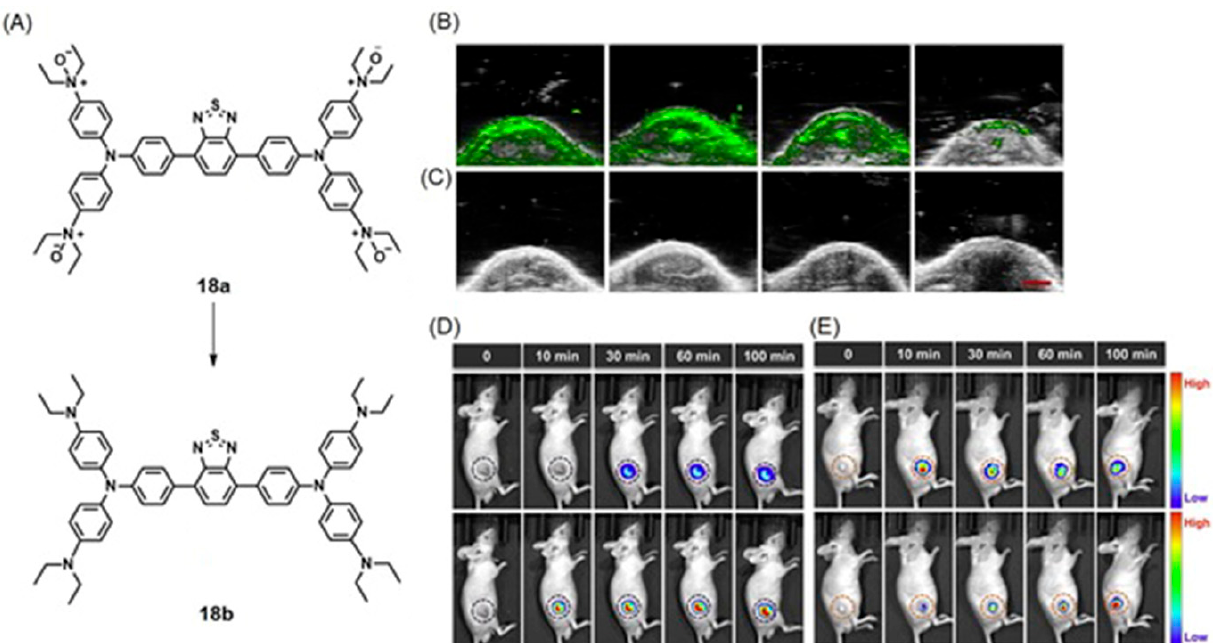
Figure 41. ( A ) Chemical structures of 18a and 18b . Time-dependent in vivo photoacoustic images of the tumor region in mice after tail vein injection of ( B ) nanoparticles of 18a (200 μ L, 1 mg mL –1 ) and ( C ) saline (200 μ L) as control. (Left to right) Images were obtained after 6, 24, 48, and 72 h post-injection of nanoparticles. Scale bar = 2 mm. A strong photoacoustic signal was detected 6 h post-injection demonstrating the responsiveness of 18a to hypoxia. ( D , E ) Time-lapse near-IR fluorescence images of mice before (0 min) and after (10, 30, 60, and 100 min) being intratumorally injected with ( D ) 18a nanoparticles and ( E ) 18b nanoparticles (50 μ L, 1 mg mL –1 ). Top panels are the fluorescence signals collected upon excitation at 500 nm, and the bottom panels are the fluorescence signals collected upon excitation at 570 nm. The fluorescence in mice injected with 18a decreases overtime with excitation at 500 nm, whereas fluorescence with 570 nm excitation increased overtime. The changes indicate the reduction in 18a upon entering hypoxic cells. Because 18b is not sensitive to hypoxia, fluorescence remained constant within 100 min post-injection regardless of the excitation wavelength. Adapted with permission [348].